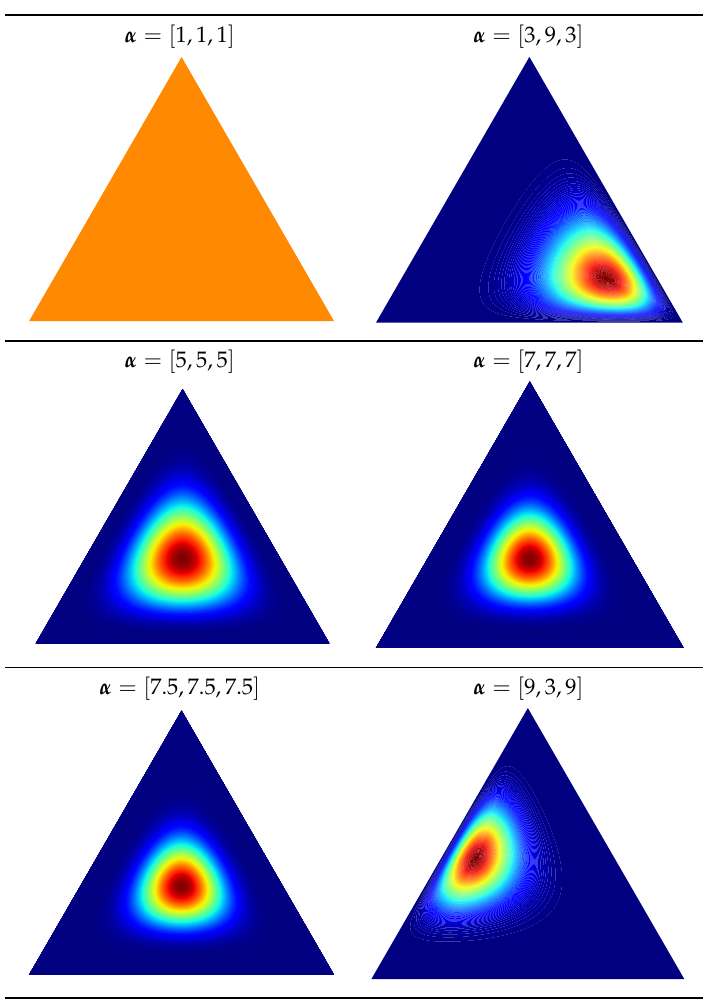
Table 1. Dirichlet